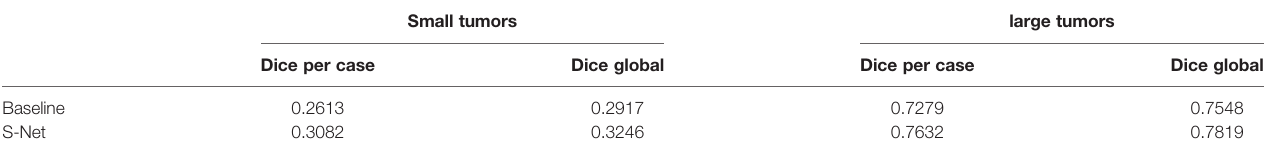
TABLE 4 | The effectiveness of our network to small and large tumors